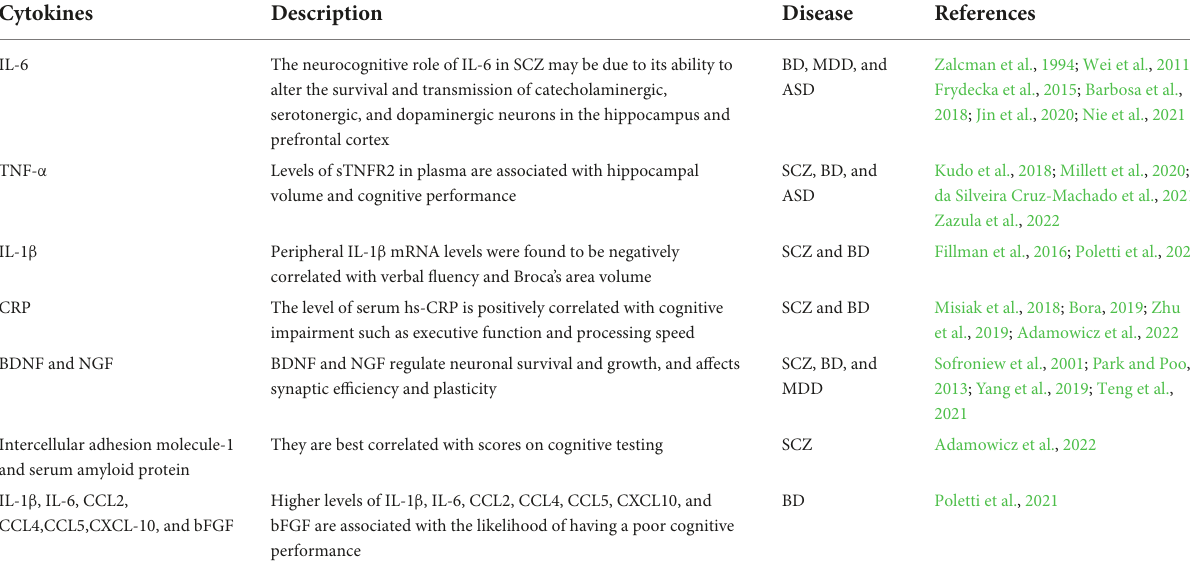
TABLE 1 Peripheral inflammatory factors and neurotrophic factors associated with cognitive impairment in psychiatric